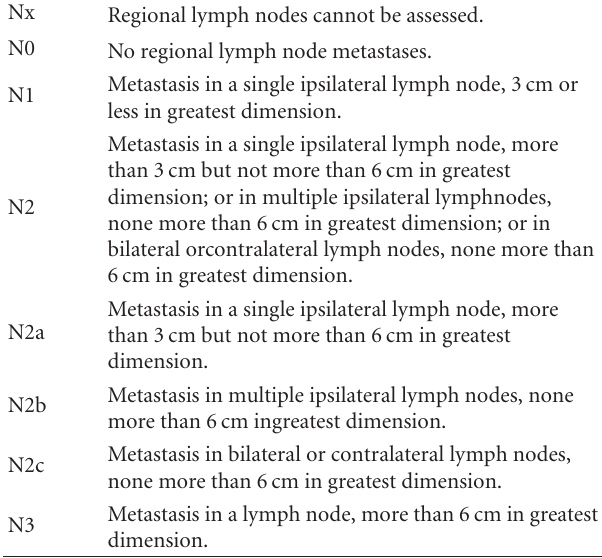
Table 3: Regional lymph nodes (N).